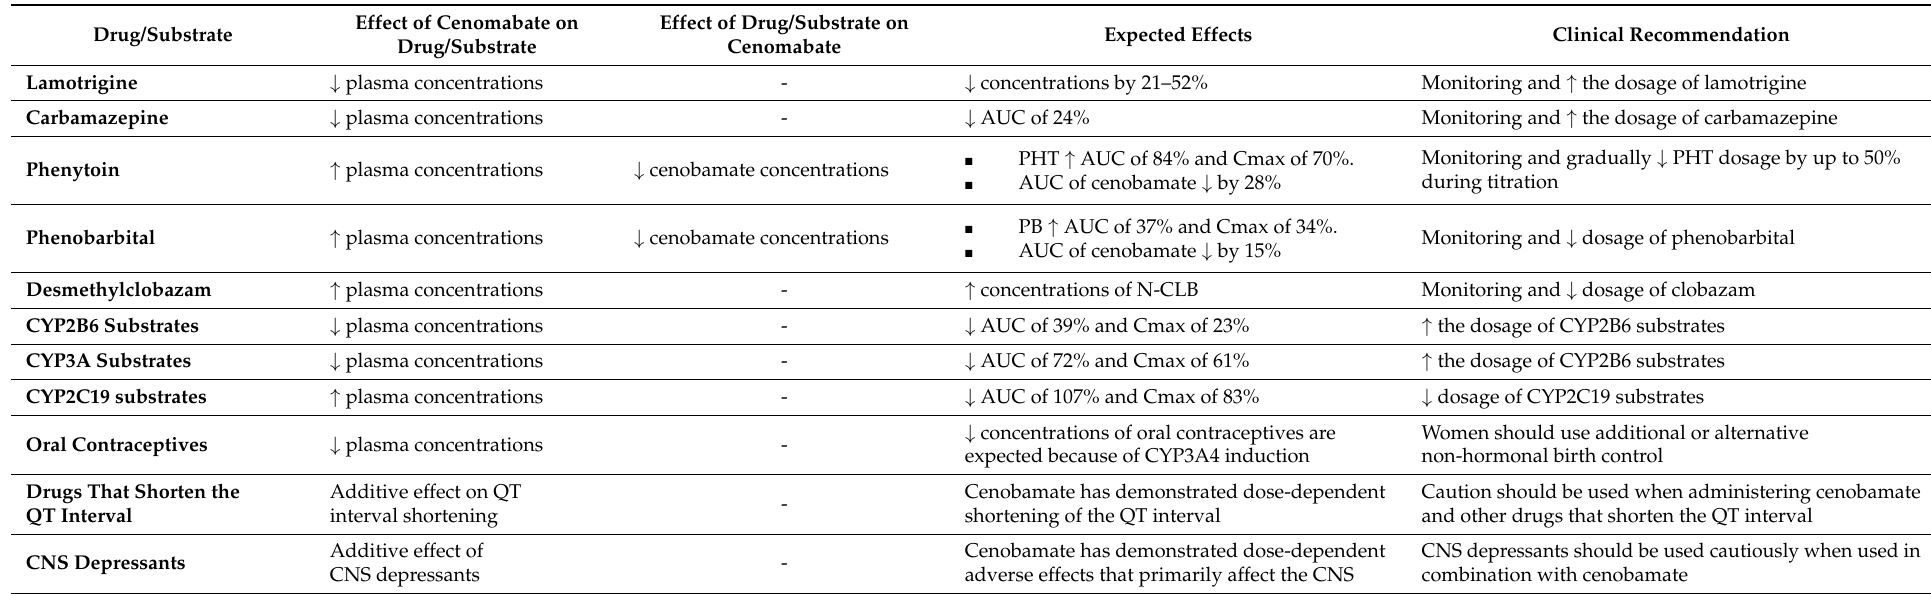
Table 1. Pharmacokinetic drug interaction of